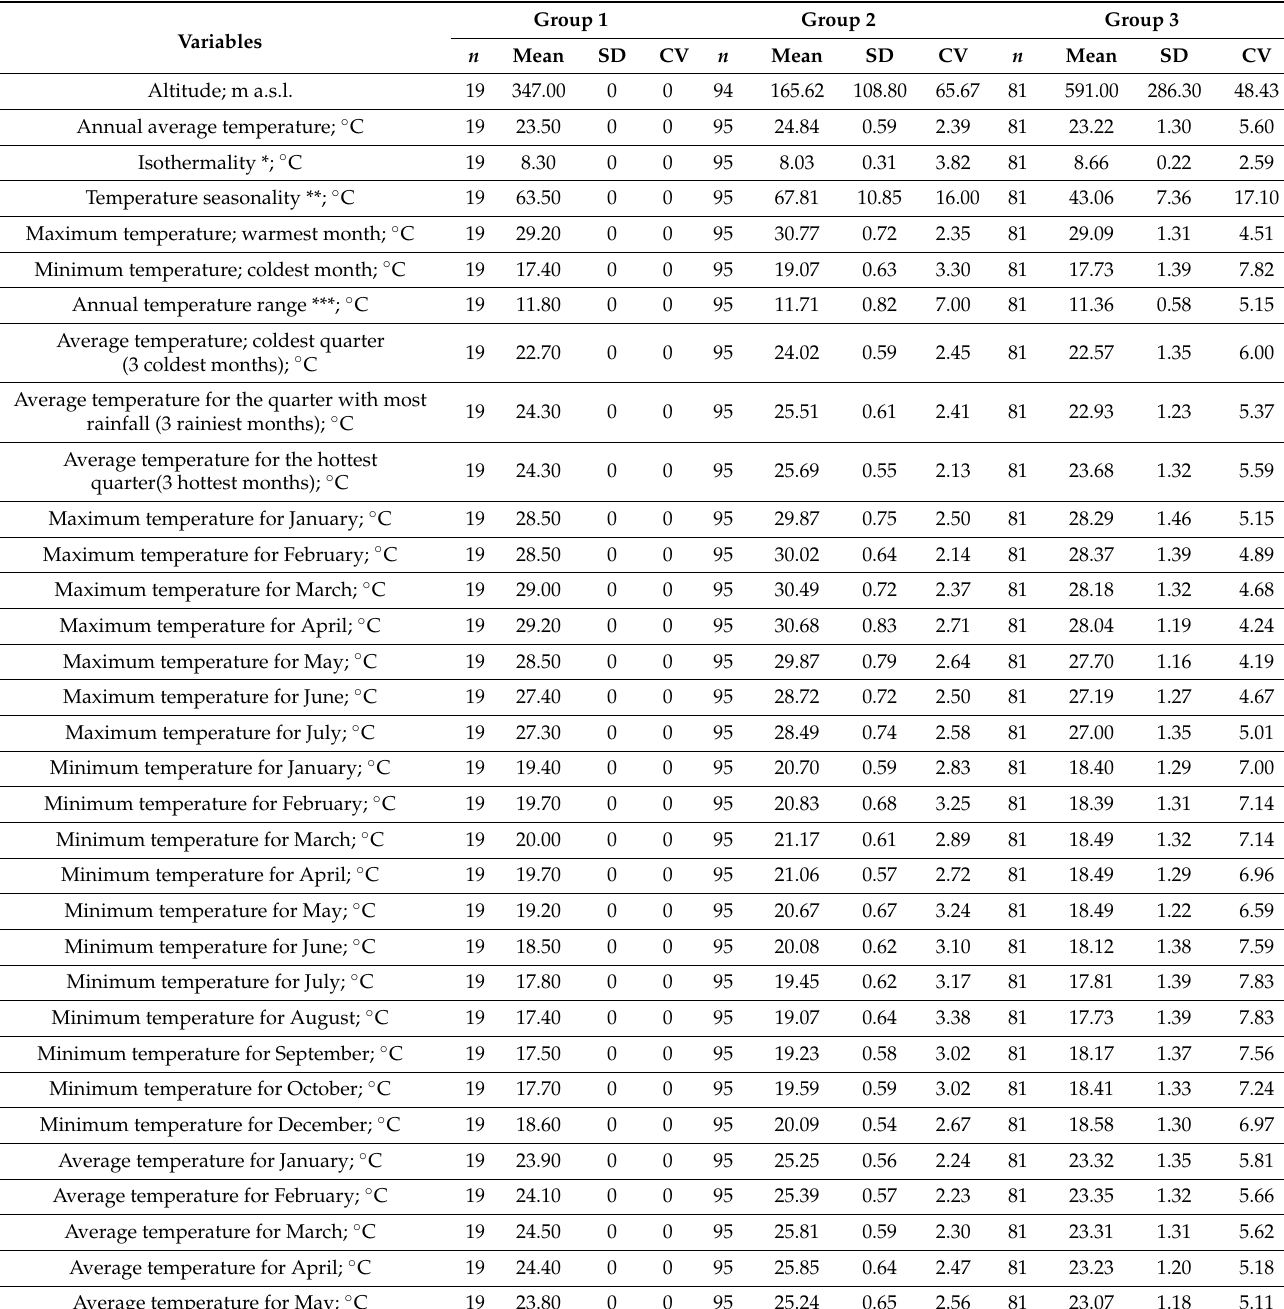
Table A4. Ecogeographic variability with quantitative characters based on the three groups obtained through multivariate analysis for the Ecuadorian cassava